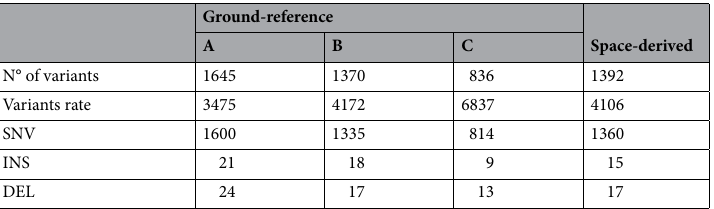
Table 1. Variant detection in the genome of ground-reference triplicates of the ground-reference of Chroococcidiopsis sp. CCMEE 029 and space-derivate. SNV single nucleotide variant, INS insertion, DEL